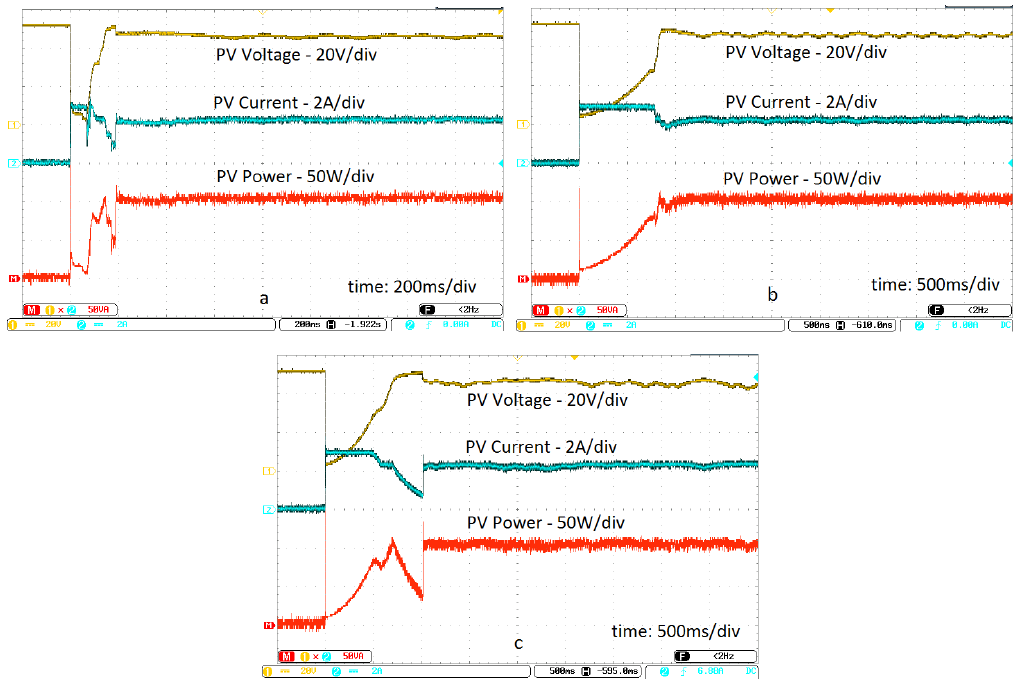
Figure 18. The results of the second PSC ( a ) Proposed algorithm; ( b ) Method in [7]; and, ( c ) Method in [28].